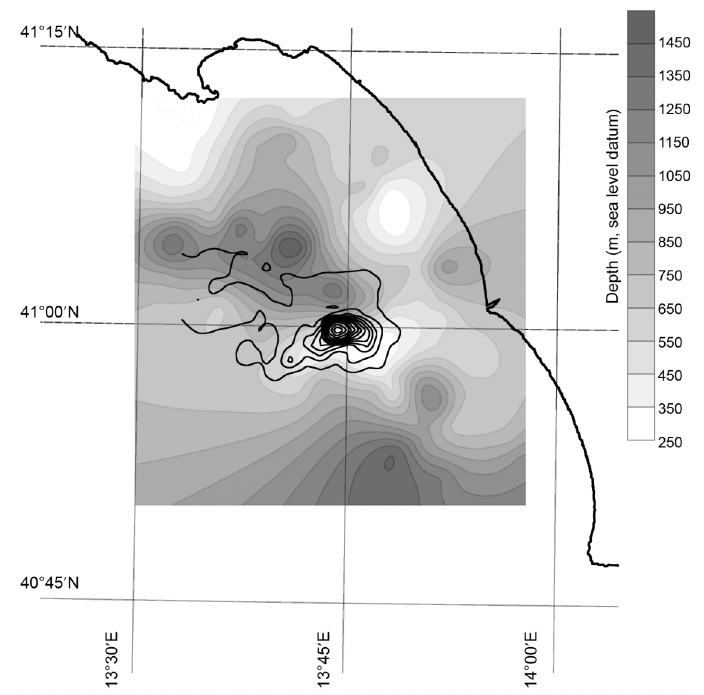
Fig. 11. 3D inversion based on the Fedi (1997) model of the magnetic anomaly (thin line contour) and depth map of the magnetic source (gray textures). The mismatch between the two maxima is in the order of 1